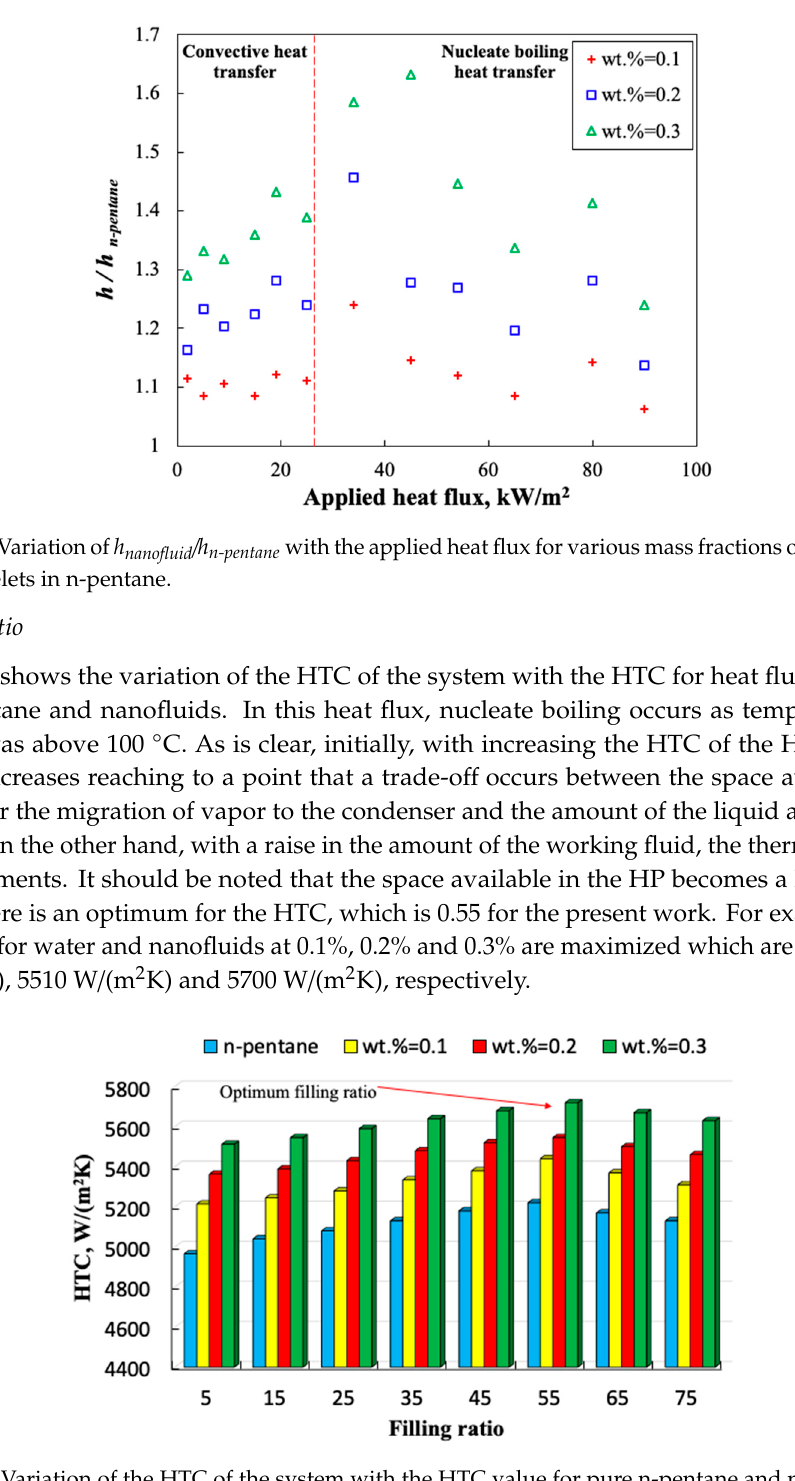
Figure 6. Variation of the HTC of the system with the HTC value for pure n-pentane and nanofluids.